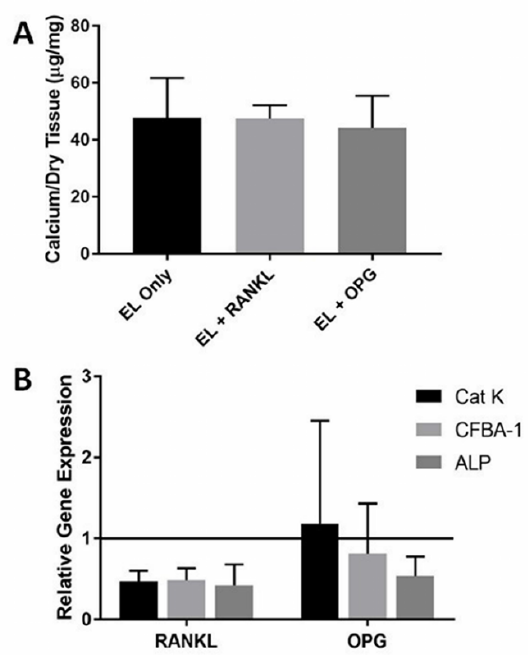
Figure 4. ( A ) RANKL and OPG injections had no effect on elastin calcification, as shown in the calcium per dry tissue weight graph above with no significant differences ( p = 0.99) ( n = 4). ( B ) RANKL injections down regulate Cat-K and bone markers CFBA-1 and ALP compared to saline controls while OPG injections only had an effect on ALP ( n = 4). Data were analyzed with ANOVA and Student’s t -test, with p < 0.05. No statistical difference was observed.